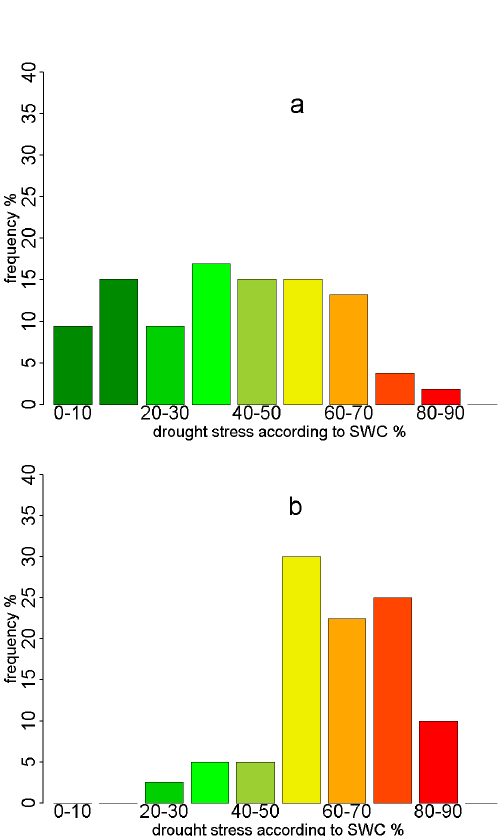
Fig. 5. Histogram of drought stress index SWC for (a) : simula- tions with measured climate data (1951–2003) and (b) : simulations with climate projections (2061–2100, WETTREG A1B normal); even site and an available water capacity of 150mm; climate sta- tion “Deuselbach”,